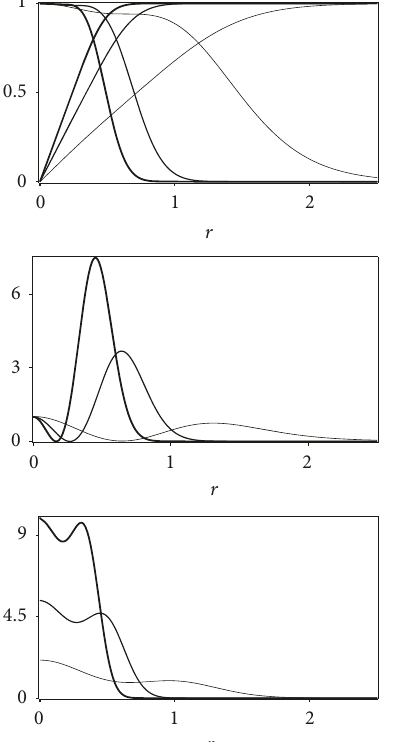
Figure 1: The solutions 𝑎(𝑟) (descending lines) and 𝑔(𝑟) (ascending lines) of (22a) and (22b) (top), the magnetic field (middle), and the energy density (bottom) of the visible sector for 𝑞, 𝑤 = 1 and 𝛽 = 4, 20 and 50 . The thickness of the lines increases with 𝛽